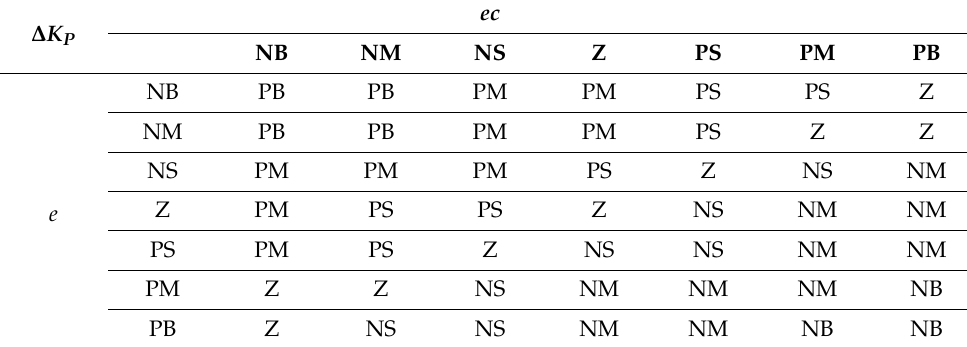
Table 1. Fuzzy control rules for ∆ K P .